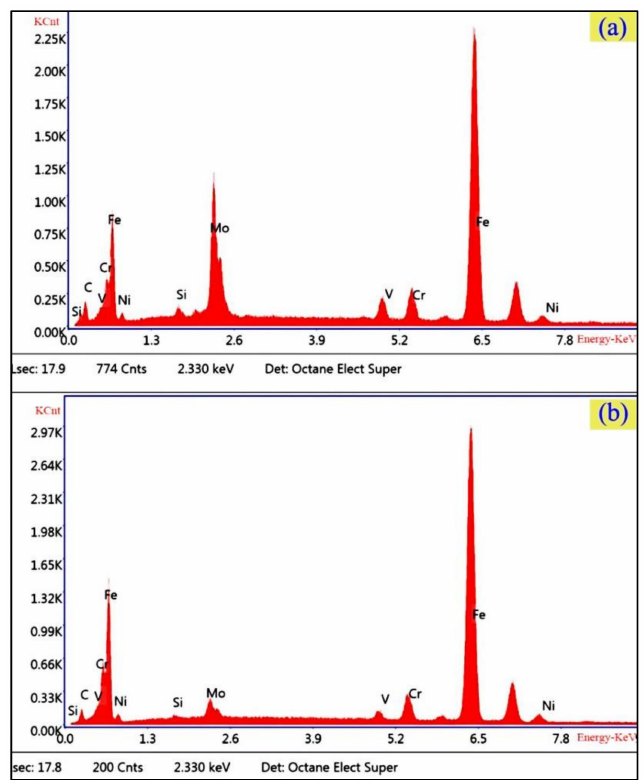
Figure 3. Energy dispersive X-ray spectroscopy (EDS) results of ( a ) the dispersed phase and ( b ) the matrix of M50NiL